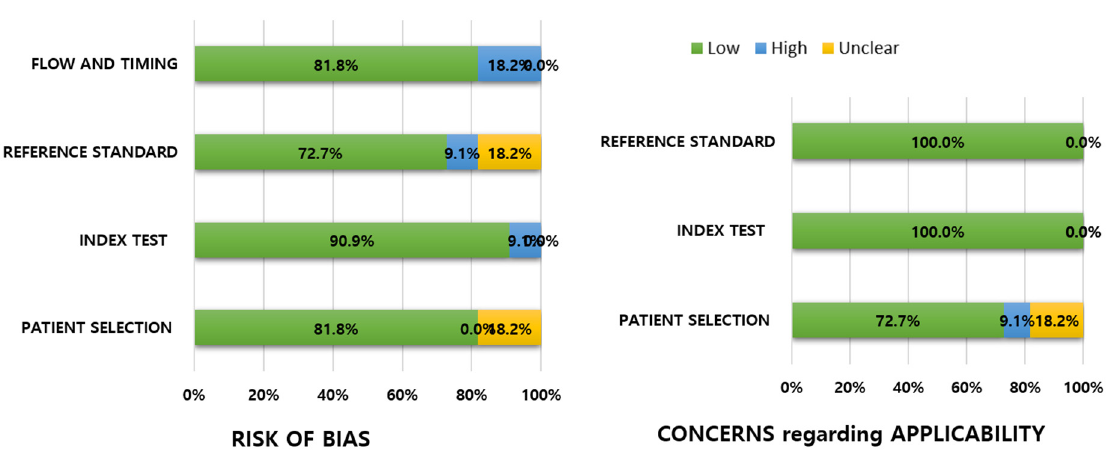
Figure 2. Grouped bar charts showing risk of bias and concern for applicability of 11 included studies assessed using Quality Assessment of Diagnostic Accuracy Studies-2 domains.